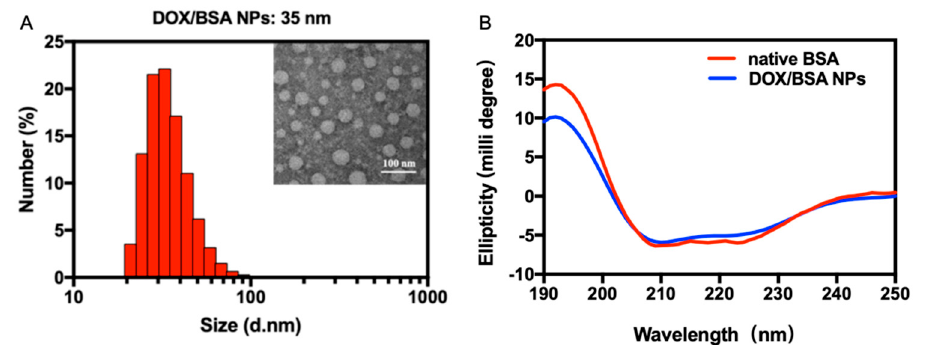
Figure 3. Characterization of secondary structure and particle size of DOX/BSA NPs. ( A ) TEM images of DOX/BSA NPs and the particle size of DOX/BSA NPs measured by DLS. ( B ) Far-UV CD spectra of DOX/BSA NPs. Representative spectra are the average of three consecutive scans and smoothed with a Savitzy − Golay least-squares fit.